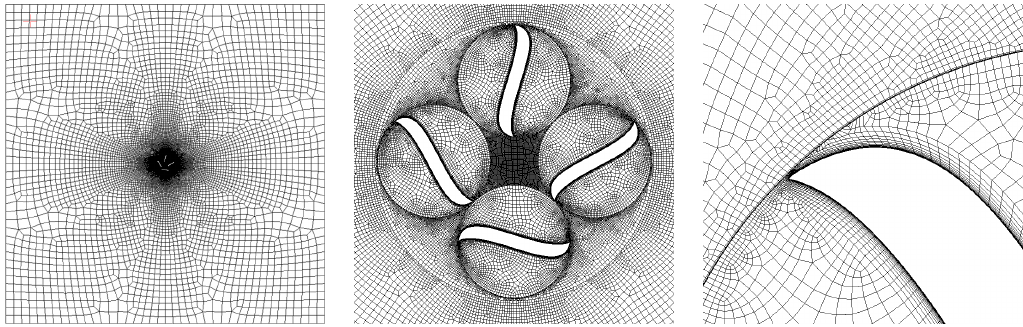
Figure 26. Global domain ( left ), mesh refinement on the interfaces ( middle ) and inflation layer on a blade tip ( right